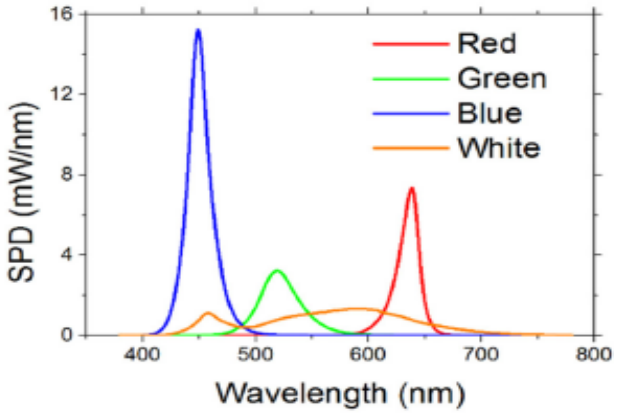
Figure 2. Parameters of the RGBW LED.